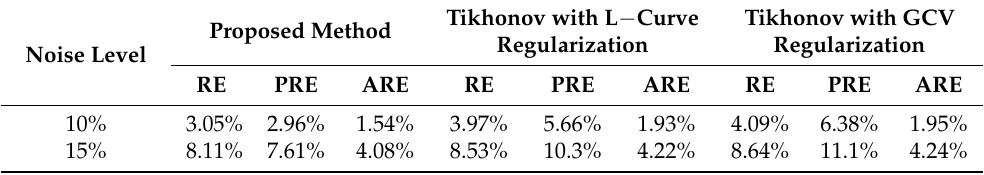
Figure 6. The identification results with 15% noise. ( a ) Proposed method; ( b ) identification error; ( c ) Tikhonov with L − curve regularization; ( d ) identification error; ( e ) Tikhonov with GCV regulariza- tion; ( f ) identification error. Table 4. Identification error in Example 2.